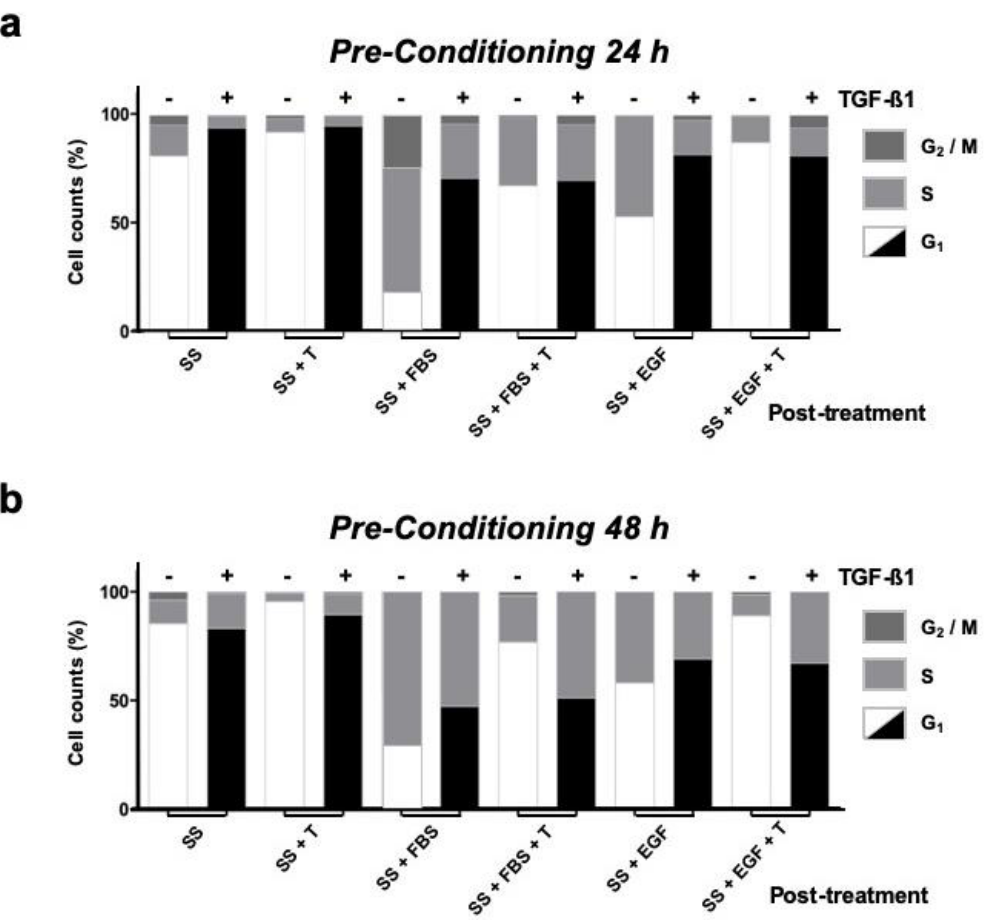
Figure 5. HaCaT cells under continuous TGF- β 1 treatment show impaired TGF- β 1 restraint with serum or EGF stimuli. Keratinocytes in serum deprived medium were conditioned by continued exposure to TGF- β 1 [+] for either 24 h ( a ) or 48 h ( b ). Untreated cells (-)were used as reference controls. Response to post-treatment stimulus was determined by flow cytometry. Black G 1 columns represent cells maintained in continuous serum deprived conditions with TGF- β 1; white G 1 columns represent control cells maintained in serum deprived conditions without TGF- β 1. SS: Serum starvation medium; + T: TGF- β 1 inoculation; + FBS: Foetal bovine serum supplementation; EGF: Epidermal growth factor inoculation. Representative data from at least three independent experiments are